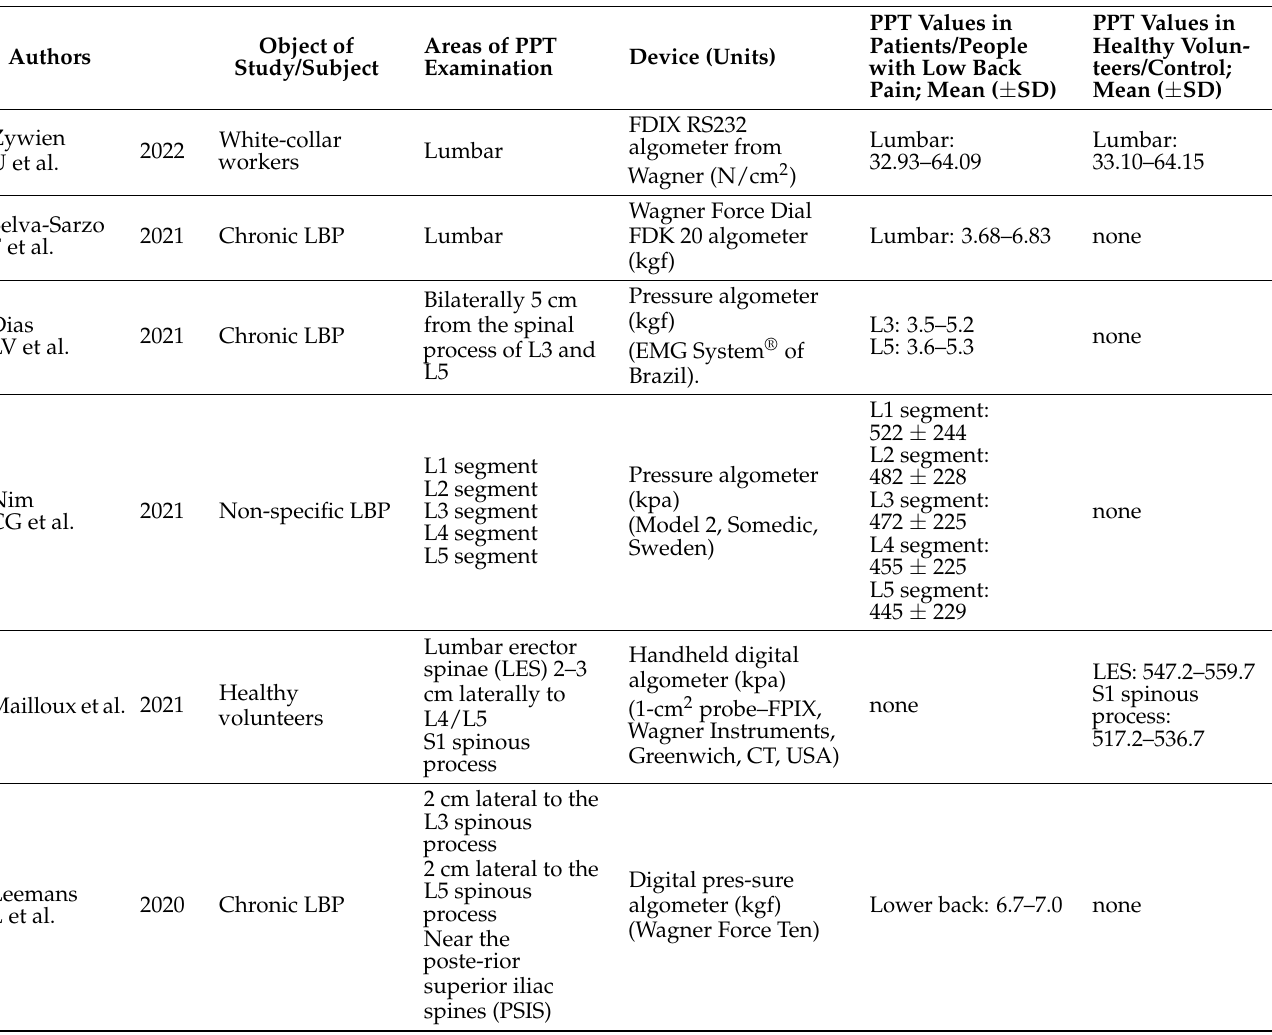
Table 3. Pressure Pain Threshold (PPT) Values of Low Back in Volunteers/Patients with and without Low Back Pain